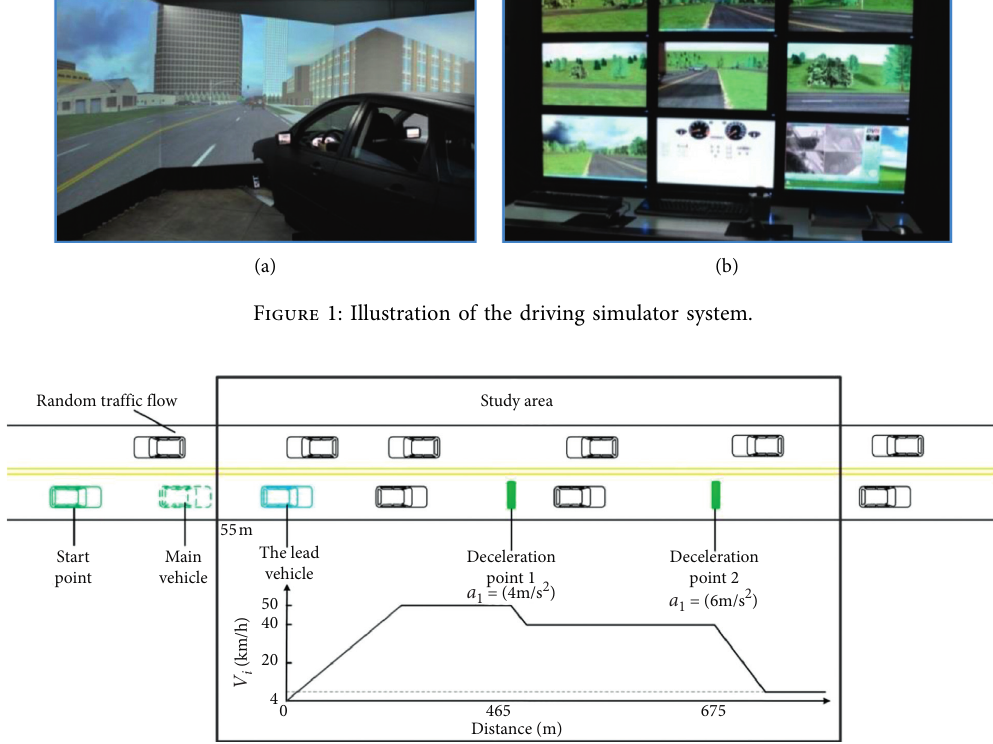
Figure 2: Details of the experimental road and study